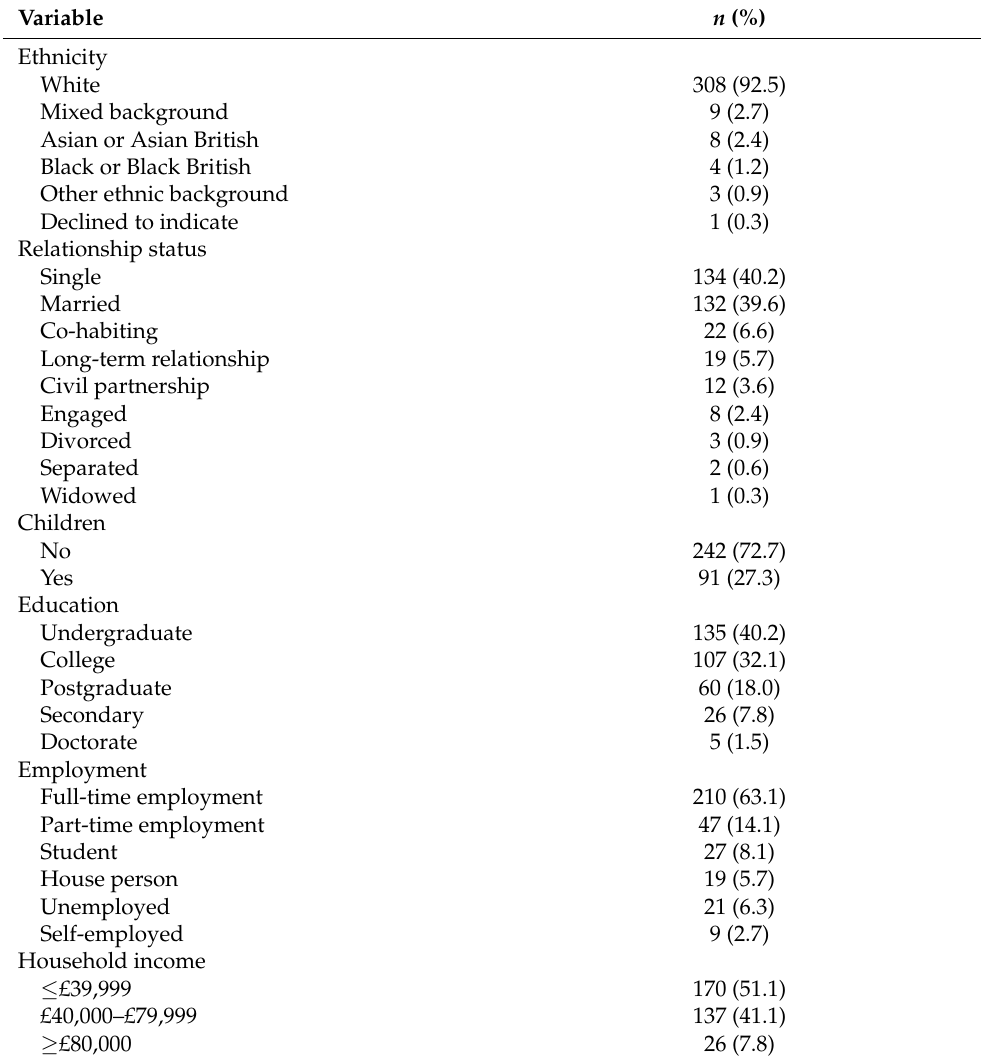
Table 1. Selected sociodemographic characteristics for the study cohort of UK women with polycystic ovary